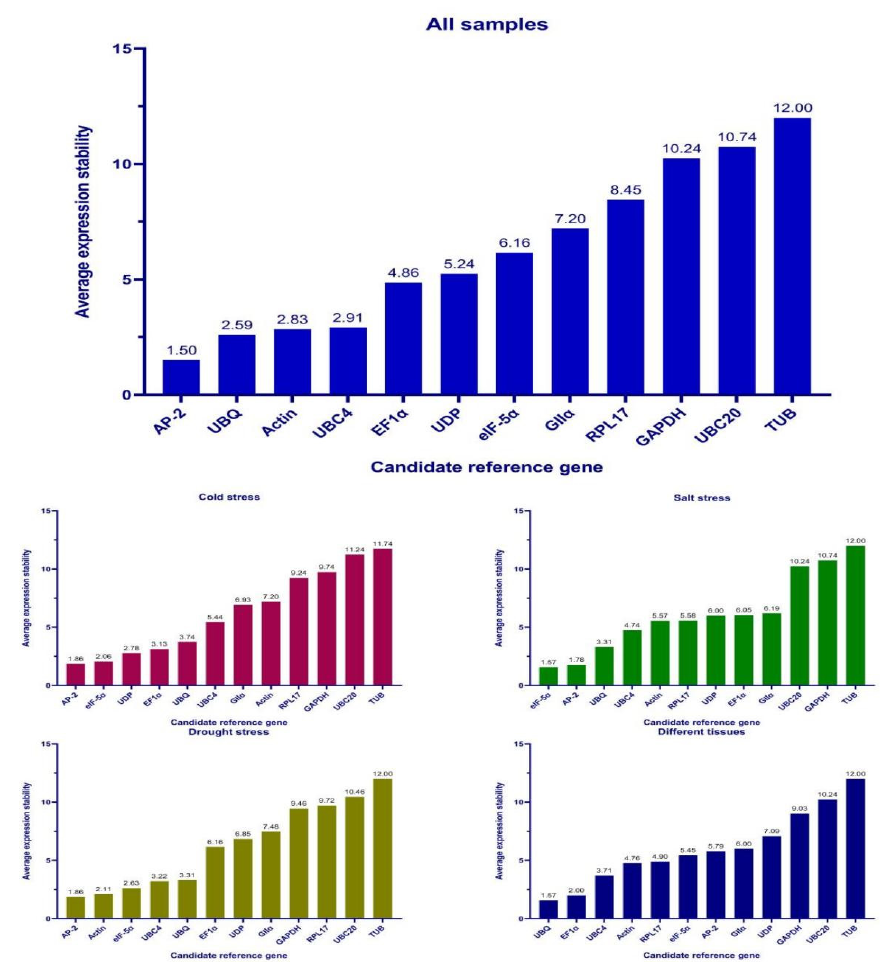
Figure 5. Comprehensive ranking of